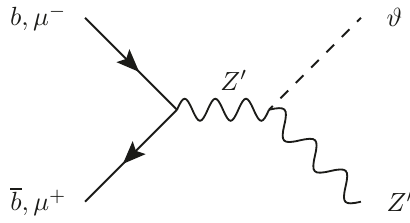
Figure 7. Flavonstrahlung at a hadron collider or a muon